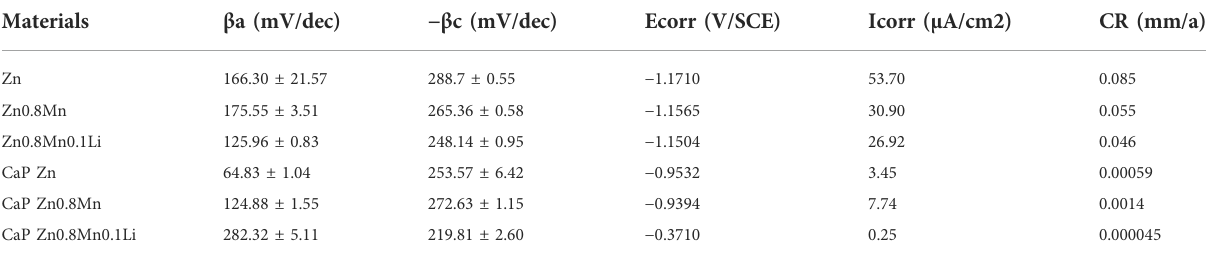
TABLE 3 Polarization data of pure zinc and zinc alloy samples in SBF.